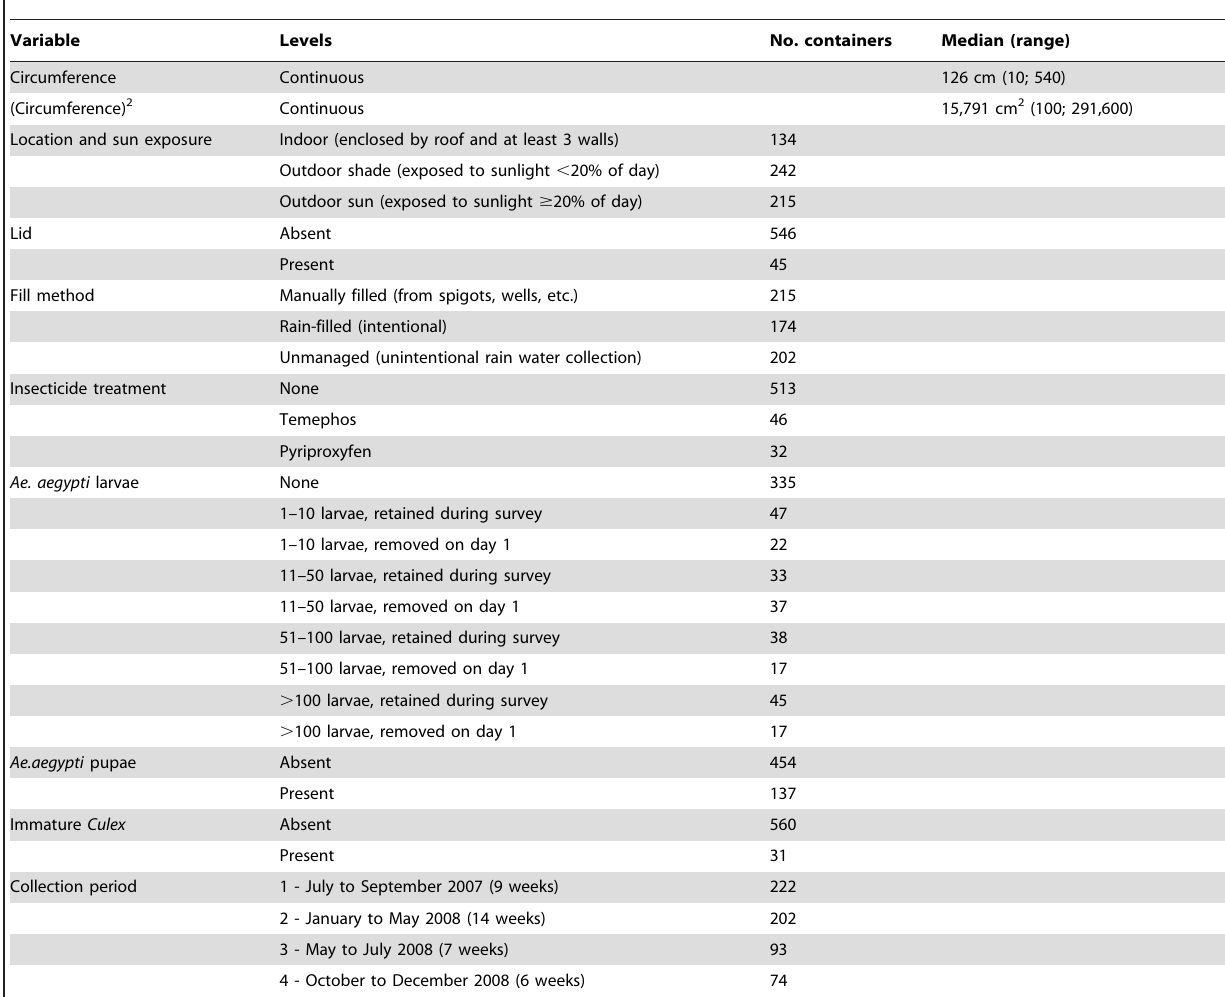
Table 1. Container characteristics recorded during oviposition survey in Iquitos, Peru, and regression parameters for oviposition